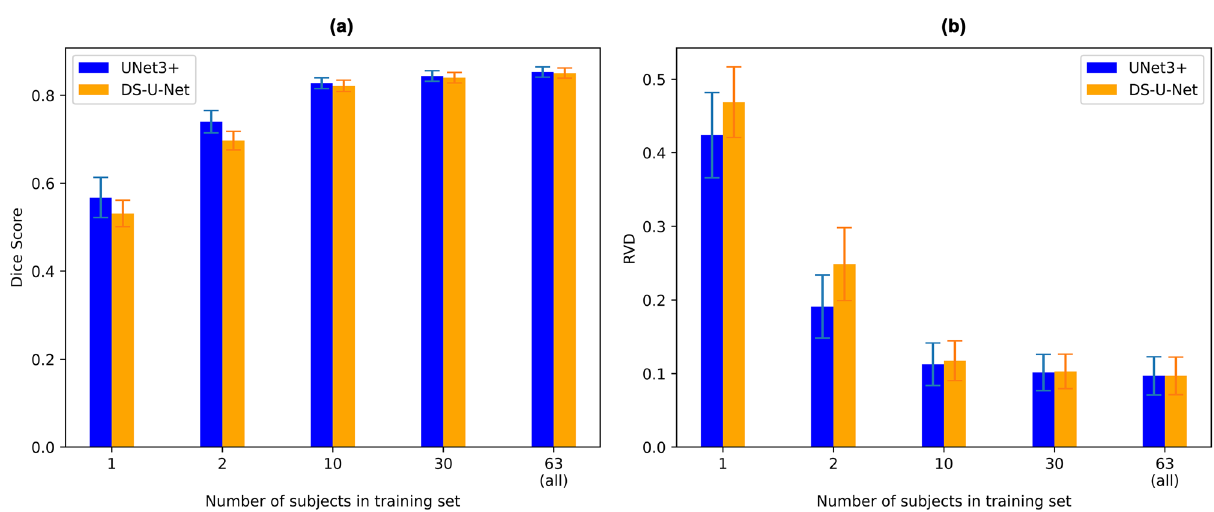
Figure 9. Segmentation performance of UNet3+ and DS-U-Net with different numbers of training subjects. ( a ) Mean Dice score across all subjects and all tracts (higher is better), and ( b ) mean RVD value across all subjects and all tracts (lower is better). Error bars indicate standard deviation for the 105 subject